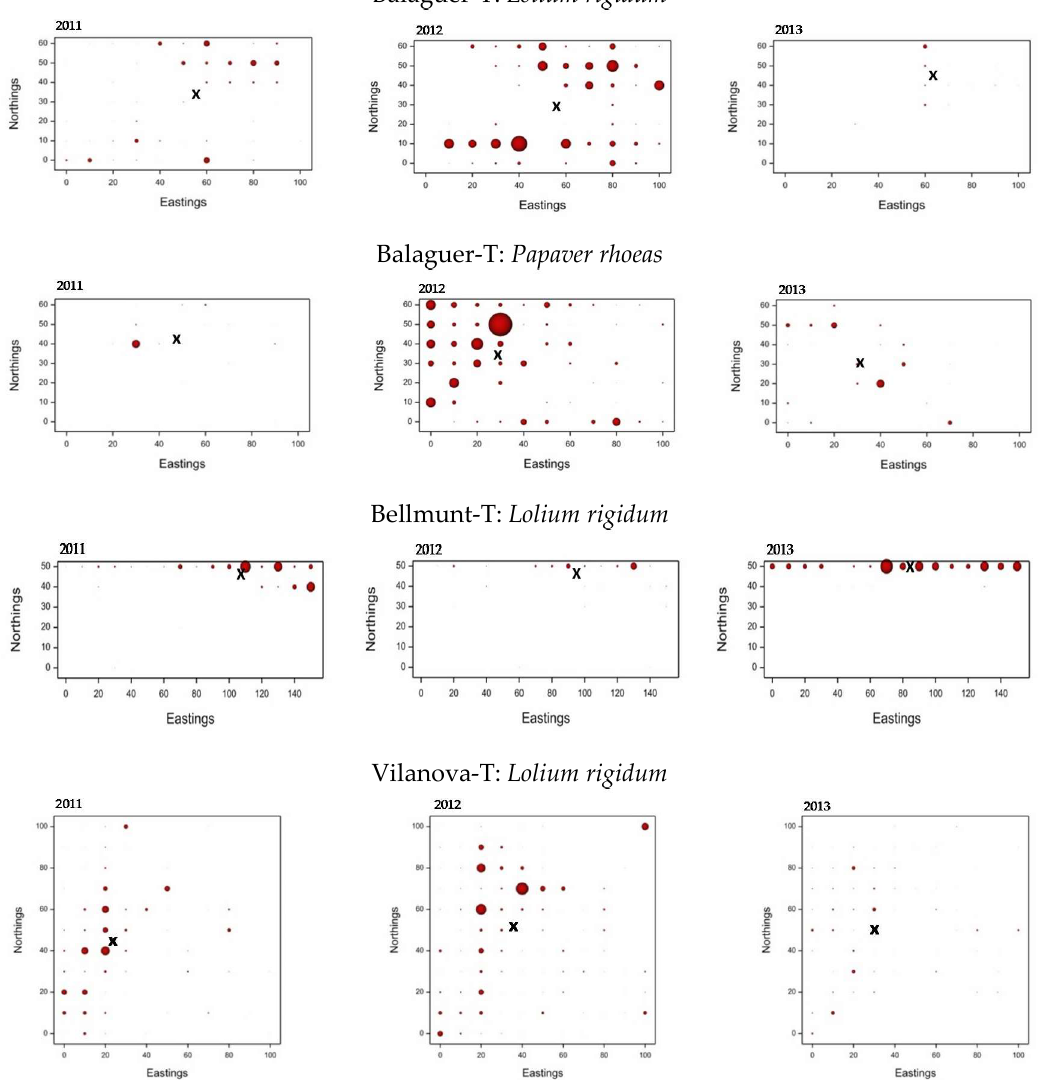
Figure 3. Maps of weed cover (%) with centers of gravity ( x ) in the fields with harrow tillage (T). Circle sizes are proportional to the percentage of weed cover: 100% 10%.